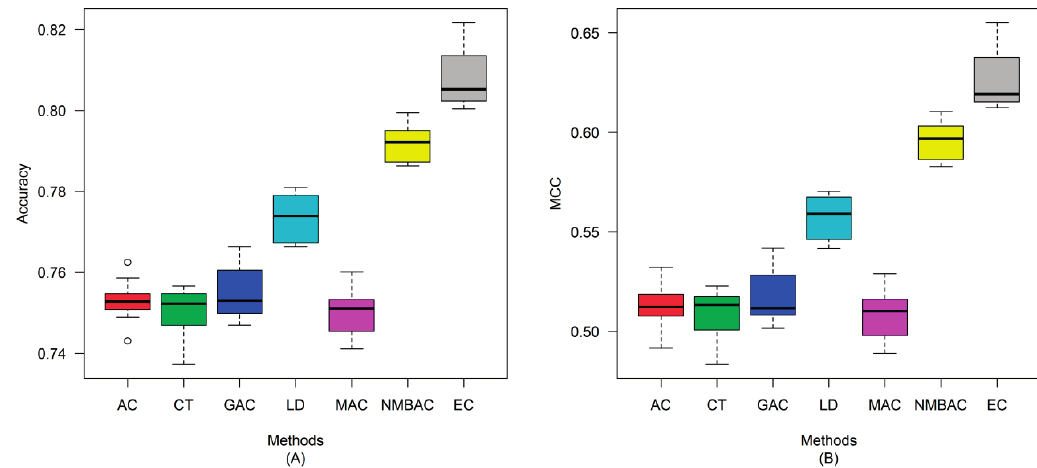
Figure 13. Average accuracy and MCC of different methods on the Gold Human dataset with five-fold cross-validation. ( A ) Accuracy; ( B ) MCC.